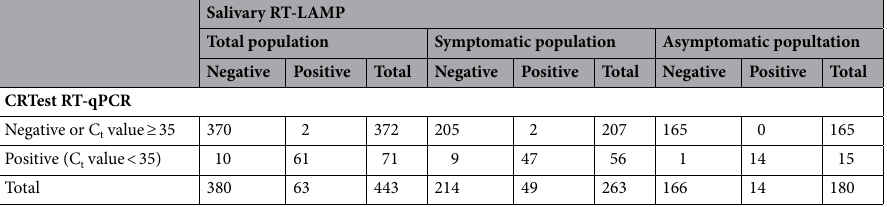
Table 2. Concordance table of salivary RT-LAMP results according to CRTest RT-qPCR results in total, symptomatic and asymptomatic populations. Data are reported as number of individuals. CRTest composite